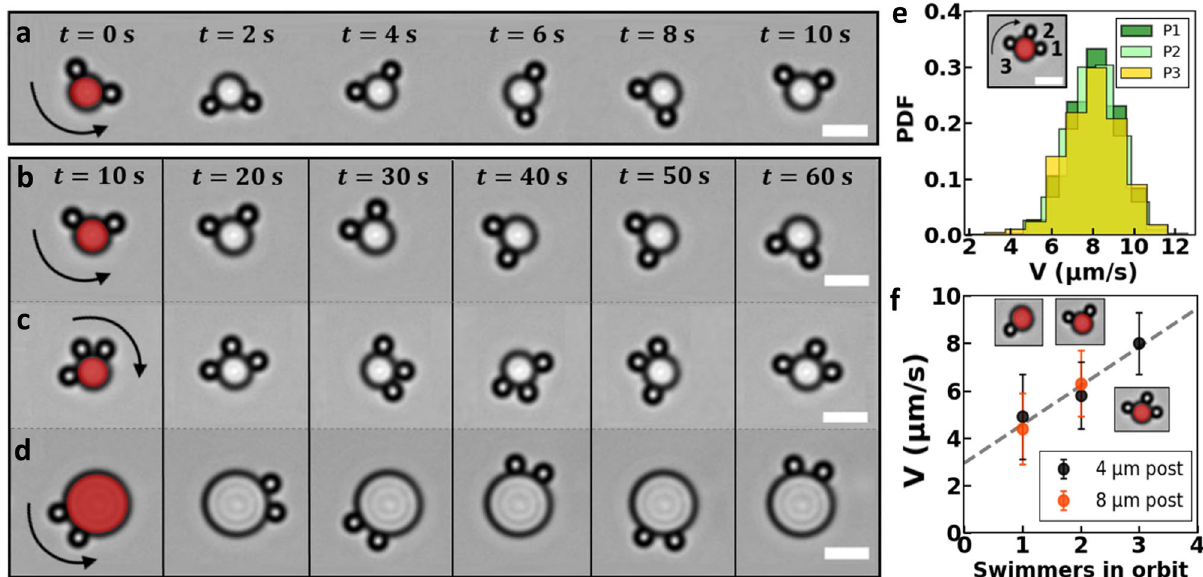
Fig. 2 Multiple microswimmers cooperatively orbit circular posts. Red color has been added to distinguish the stationary posts from the orbiting swimmers. Scale bars are 5 μ m. Sequence of light microscopy images showing orbiting of a , b two and c three swimmers around a 4 μ m diameter post, and d two swimmers around an 8 μ m diameter post. See also Supplementary Movies 2 – 4. Each column in panels b – d shares the same timestamp, indicated in b . e The probability density functions (PDFs) of propulsion speed in orbit for three swimmers on a post are almost identical. f Average propulsion speed as a function of the number of swimmers in orbit for two post sizes, showing that speed increases with the number of comoving swimmers for both post sizes in a similar fashion. All measurements were taken under the same experimental conditions. The dashed line is a least-squares fi t with y = α x + b , with α and b being (1.6 ± 0.2) μ m/s and (2.9 ± 0.4) μ m/s,